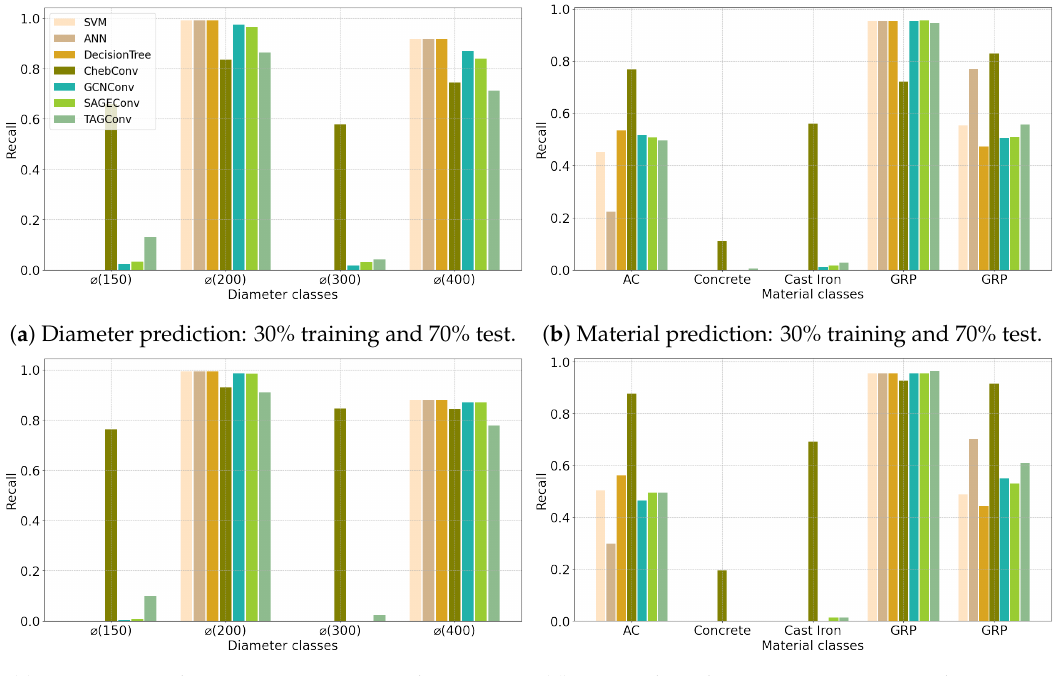
( c ) Diameter prediction: 70% training and 30% test. ( d ) Material prediction: 70% training and 30% test. Figure 6. Configuration 1: Diameter and Material prediction for the Montpellier dataset for each class of the two attributes, evaluated using Recall